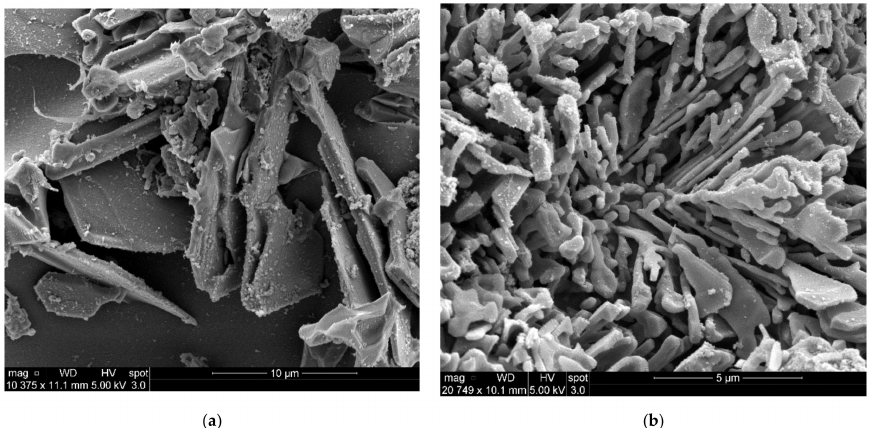
Figure 10. Backscattered electron micrographs showing the effects of the addition of Sr on Si mor- phology in grain-refined Al-11%Si alloy in the as-cast condition. ( a ) Alloy without Sr (non-modified alloy); ( b ) Alloy with 200 ppm Sr (high Sr content).